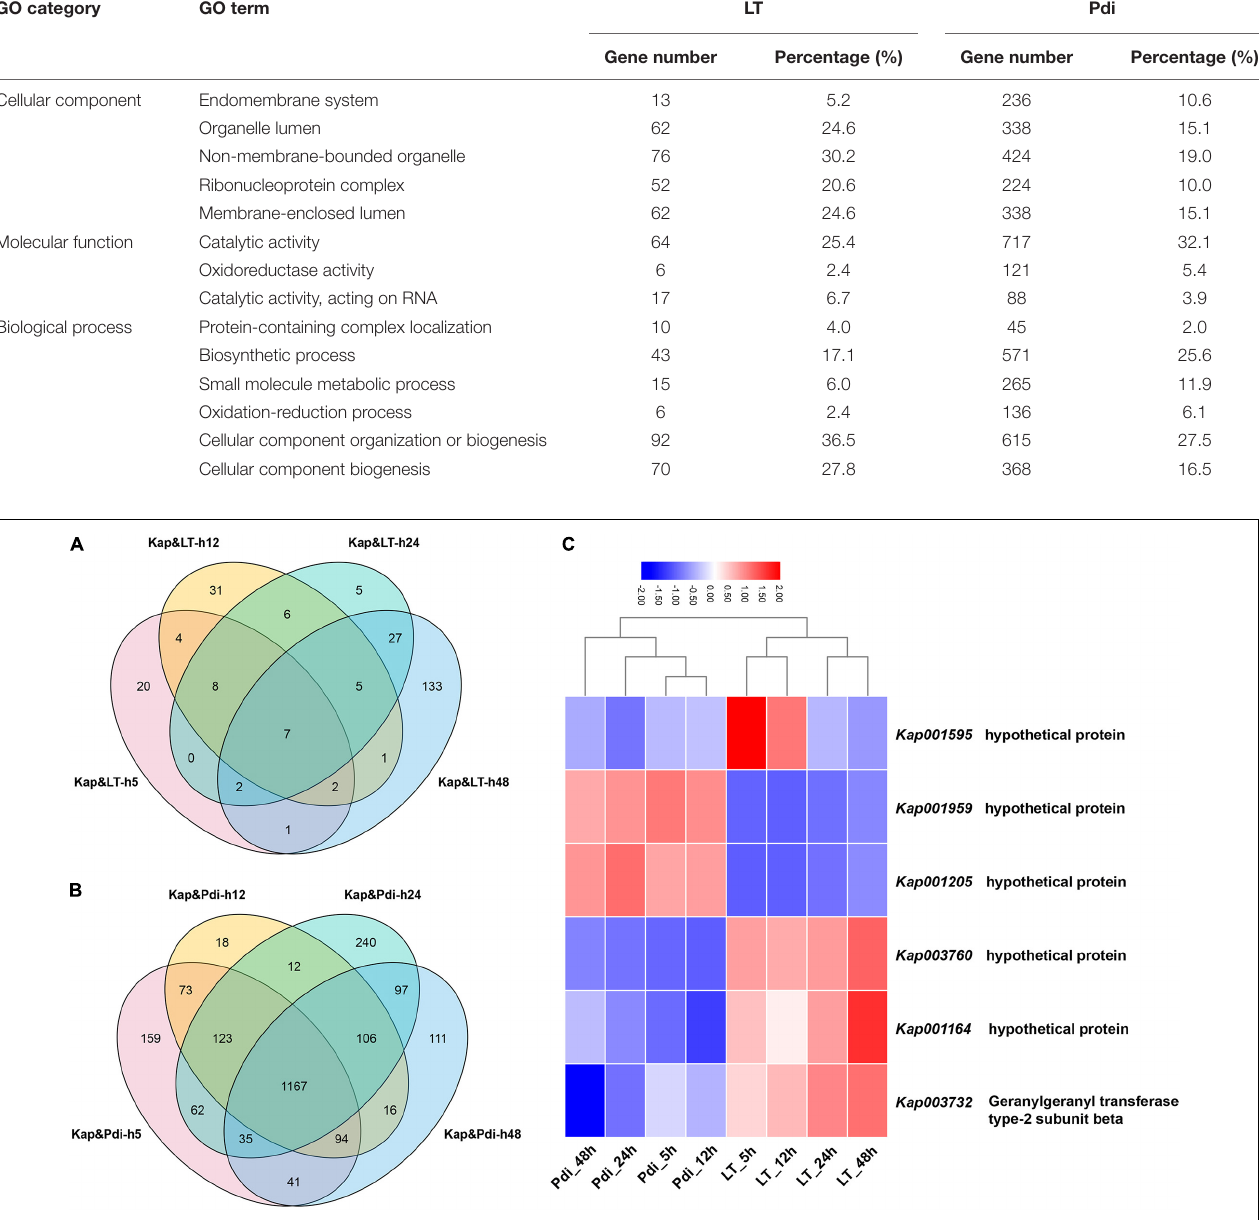
FIGURE 2 | Veen diagram of differentially expressed genes. (A) Differentially expressed genes (DEGs) after low temperature treatment. (B) DEGs after co-incubation with Penicillium digitatum. (C) Heat map of co-DEGs (CEGs) between LT and Pdi at the four time points. “Kap,” “LT,” and “Pdi” are K. apiculata 34-9 incubated in 25 ◦ C, 4 ◦ C and co-incubation with P. digitatum in 25 ◦ C, respectively. “h5,” “h12,” “h24,” and “h48” are yeast samples harvested after incubation for 5, 12, 24, and 48 h, respectively.